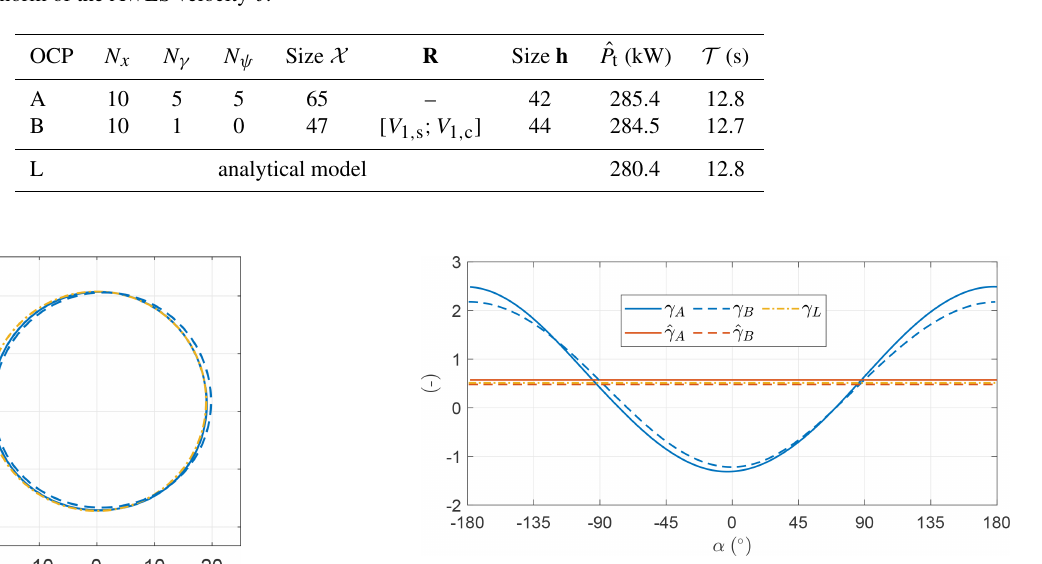
Table 2. Settings of the two optimal control problems maximizing the mean thrust power considering gravity. V 1 , s and V 1 , c are the first Fourier coefficients of the norm of the AWES velocity v .